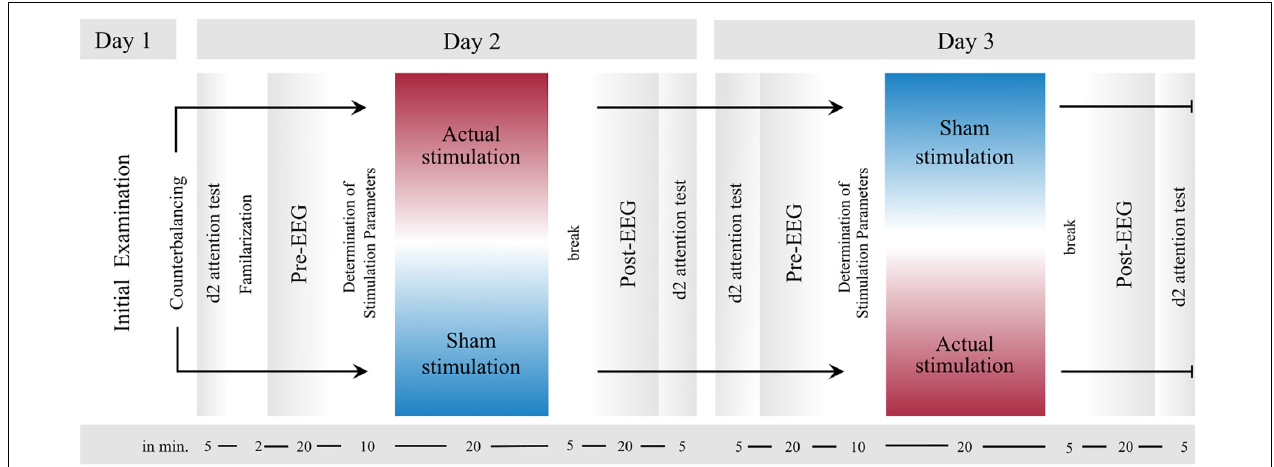
FIGURE 1 | Experimental Design. After an initial examination (Day 1), the two experimental sessions (Day 2 and Day 3) proceeded in the same order, except for a brief familiarization with the visual oddball task (VOT, cf. section “Visual Oddball Task”) in the first experimental session. First, the d2 attention test was performed before all electrodes were attached to the participants’ head. Next, the first block (pre-intervention) started, in which participants accomplished the VOT. Immediately thereafter, there was a short break, during which the tACS parameters were computed from the EEG data of the first block. As soon as these parameters were collected, the second block (intervention) started, during which actual stimulation or sham stimulation was applied. Finally, the third block (post-intervention) started after a short break. During all three blocks EEG was measured. Last, the d2 was conducted